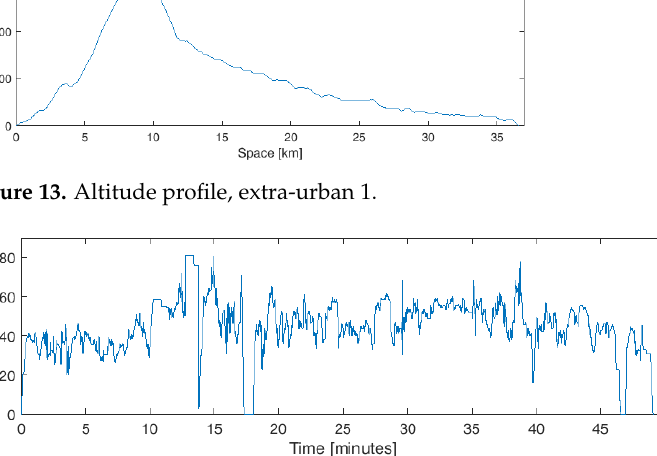
Figure 14. Speed profile, extra-urban 1.